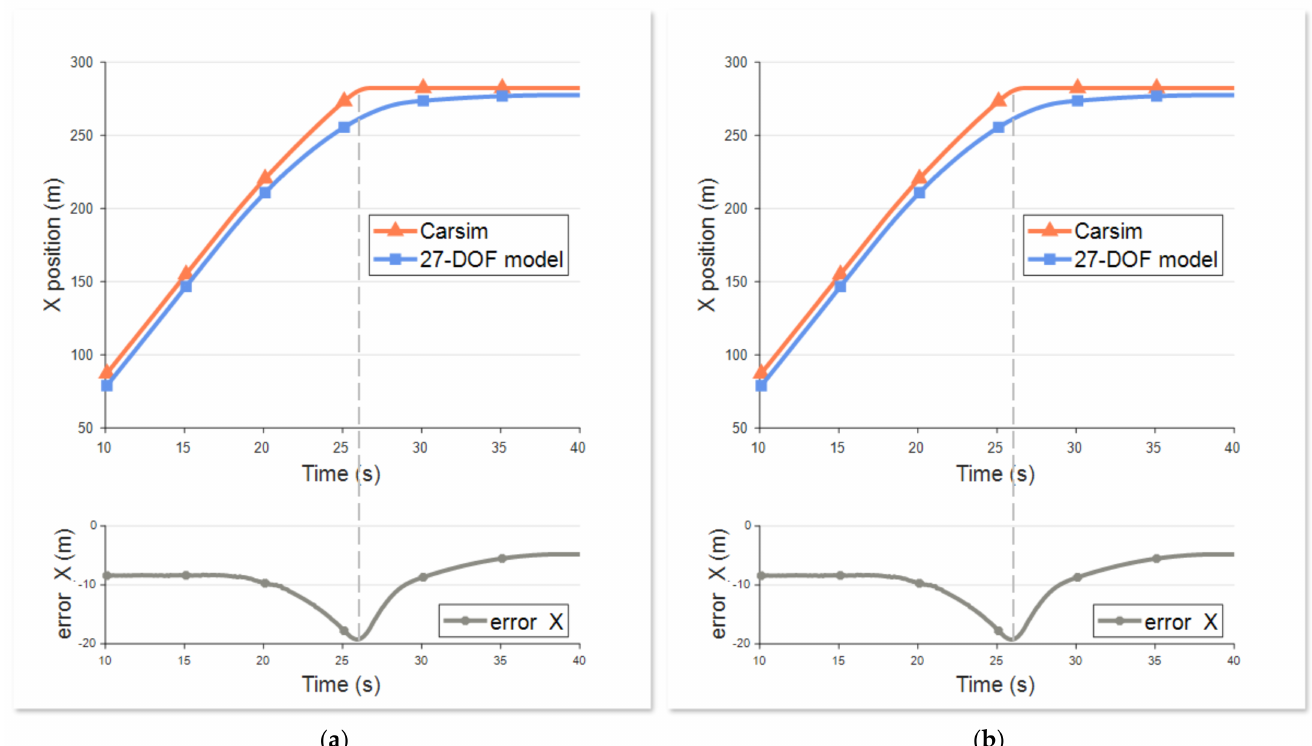
Figure 9. Vehicle position of the 27-DOF model and CarSim in the double lane change scenario of unsaturated steering condition. ( a ) X Position. ( b ) Y